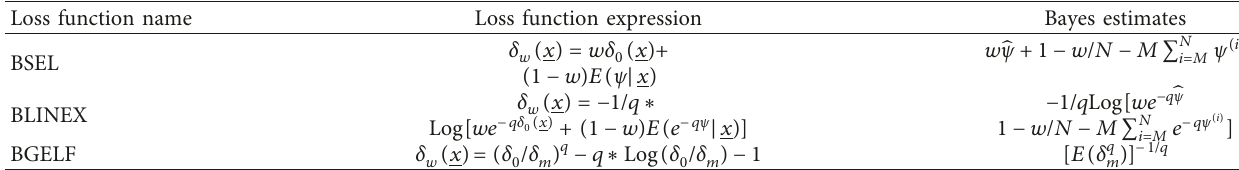
Table 2: Loss functions and their corresponding form of the Bayes